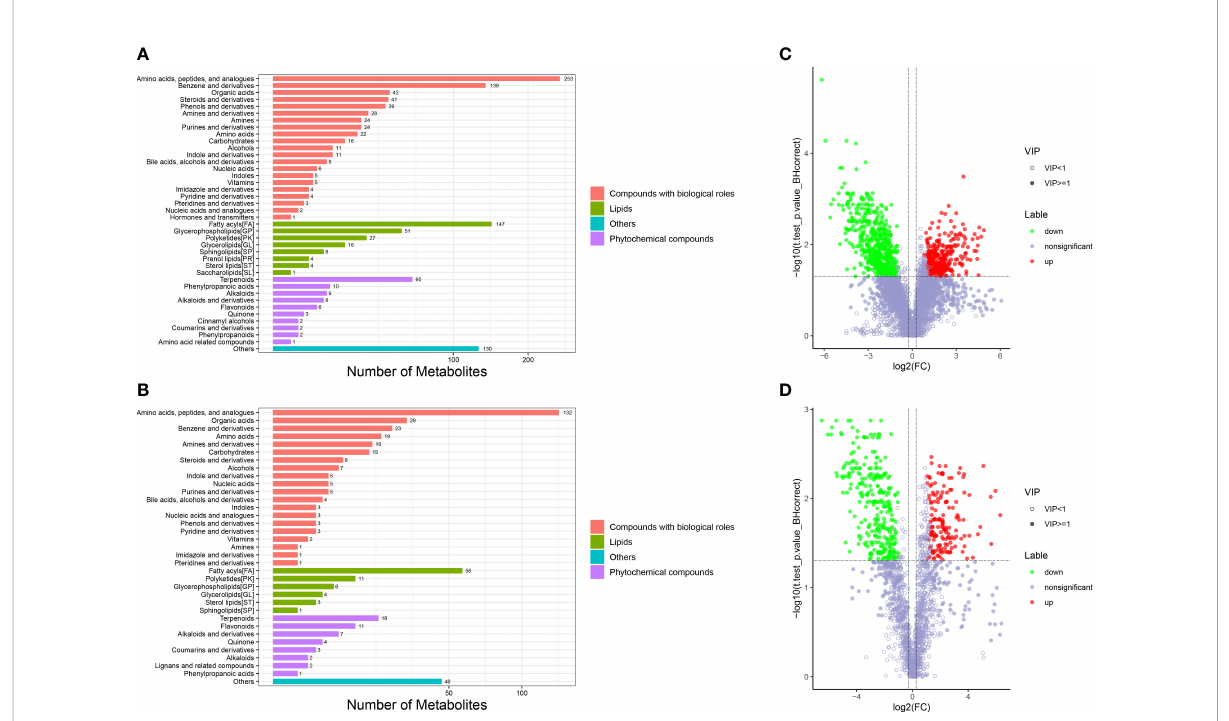
FIGURE 7 Taxonomic annotation of identi fi ed metabolites and volcano plots of DMs from the intestine of M. japonicus . (A) Taxonomic annotation of positive ion mode. (B) Taxonomic annotation of negative ion mode. Others means that the classi fi cation information is other categories, and the identi fi ed metabolites without classi fi cation information do not participate in the statistics. (C) Volcano plot of positive ion mode. (D) Volcano plot of negative ion